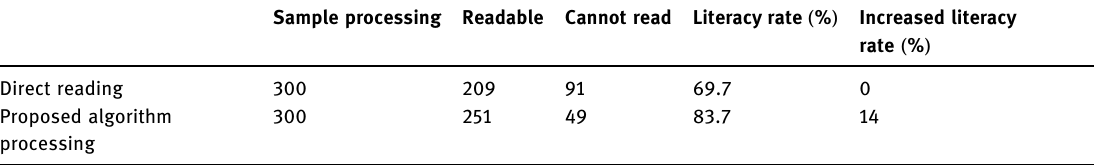
Table 1: Test result data